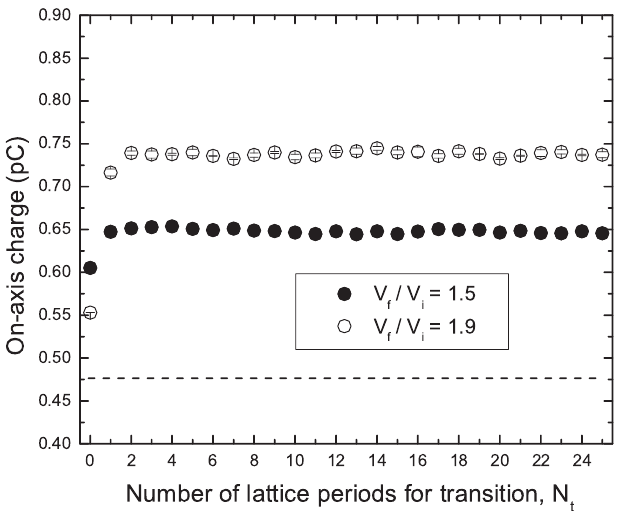
(cid:2) 1 : 5 . The transitions are =V f i FIG. 4. Measured on-axis charge dependence on the number (cid:2) 4 t N of lattice periods for transitions with V (cid:2) 20 (open circles). t t (cid:2) 1 : 9 (open circles) for (cid:5) sf =V circles) and V is 49 : 8 (cid:3) , f i vi (cid:2) 0 corresponds to an instantaneous transition. In 60 kH z . N t Fig. 4, the on-axis charge prior to the transition is 0.476 pC, which is indicated by dashed